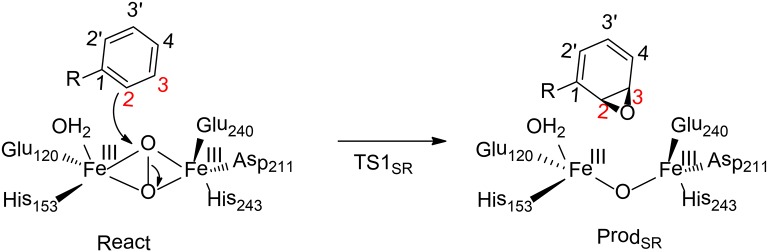
Reaction catalyzed by BoxB (Liao and Siegbahn, 2015).